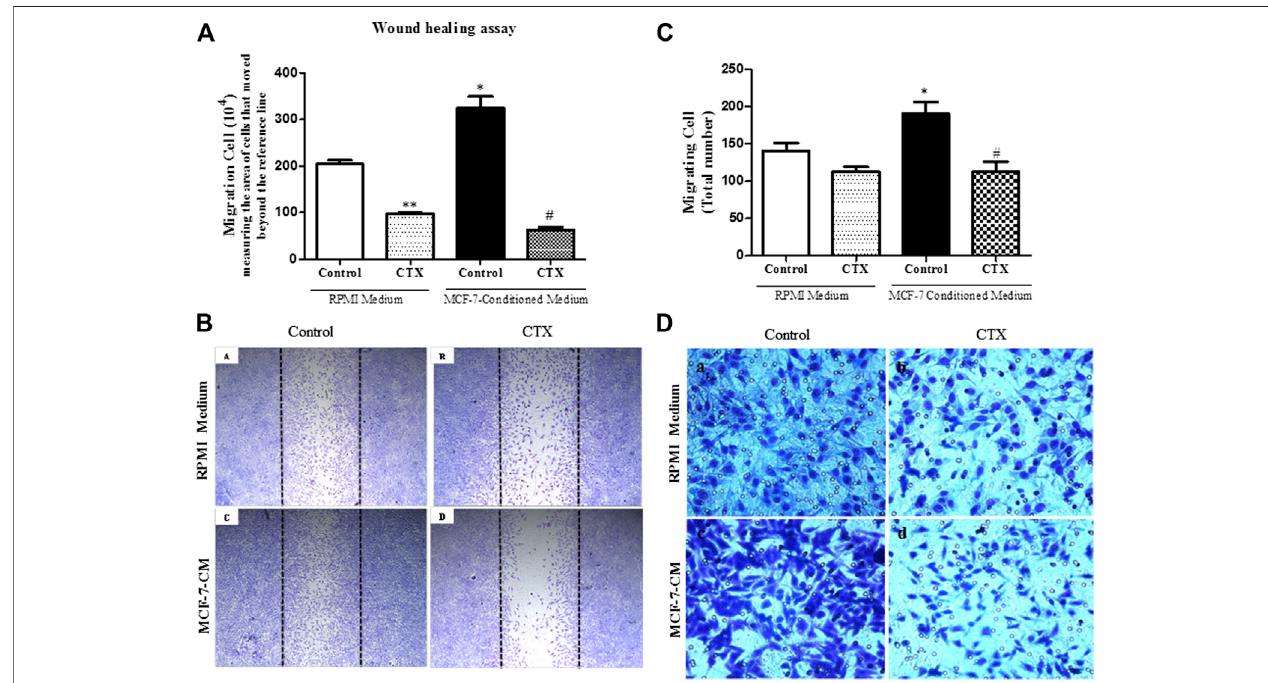
FIGURE 4 | Effect of the CTX on migration assay induced by MCF-7-Conditioned medium. (A) Wound healing assay performed in CTX-pretreated t.End.1 cells in the presence of RPMI medium containing 10% FBS (control) or in the presence of MCF-7-conditioned medium (chemotactic stimulation) for a period of 24 h. After this time, cells were fi xed by the Rosenfeld panchromic method. A total of fi ve random fi elds per coverslip were counted under a bright fi eld microscope (Standard 25; Carl Zeiss,Germany)usinga × 10objective. Theresultsareexpressed asNumberofMigratedCellsandrepresent themean ± s.e.m.Thedataarepresentedfromthree distinct experiments run in quadruplicate of each group. * p < 0.001 compared to RPMI control group. ** p < 0.001 compared to RPMI control group. # p < 0.001 compared to MCF-7-CM control group. The images represented in (B) in Panels (a – d) were obtained in a × 5 objective. Panel (a) represents control cells incubated in RPMI 1640 medium with 10% FBS; Panel (b) represents cells treated with CTX and incubated in RPMI 1640 medium with 10% FBS; Panel (c) represents control cells incubated in MCF-7-CM and Panel (d) represents CTX treated cells and incubated in MCF-7-CM. For the Transwell assay, in (C) the number of migrating cells was determined by counting in fi ve random fi elds per membrane using light microscopy. The results are expressed as Migrant Cells and represent the mean ± s.e.m. * p < 0.001 compared to RPMI control group. # p < 0.01 compared to MCF-7-CM control group. (D) The panels are representative of t.End.1 cell chemotaxis: (a) control in response to RPMI 1640 medium with 2% FBS; (b) CTX in response to RPMI 1640 medium with 2% FBS; (c) control in response to MCF-7-CM; (d) CTX in response to conditioned medium from MCF-7 tumor cells. The images were collected under an Olympus BX 51 microscope using the Image-Pro Plus 5.1 program, using a × 40 objective. The data are presented from three distinct